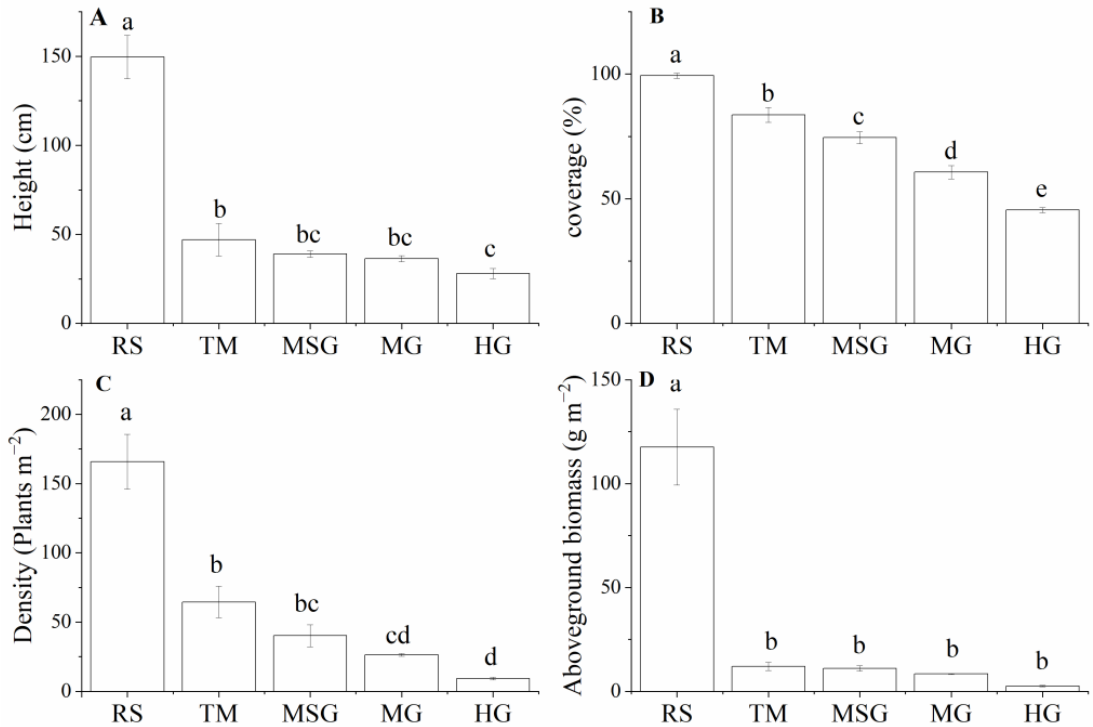
Figure 1. Plant height ( A ), coverage ( B ), density ( C ), and aboveground biomass ( D ) in the wetlands under different land uses. The bars represent the standard errors of the mean values. Different lowercase letters indicate significant differences among five wetlands ( p < 0.05).